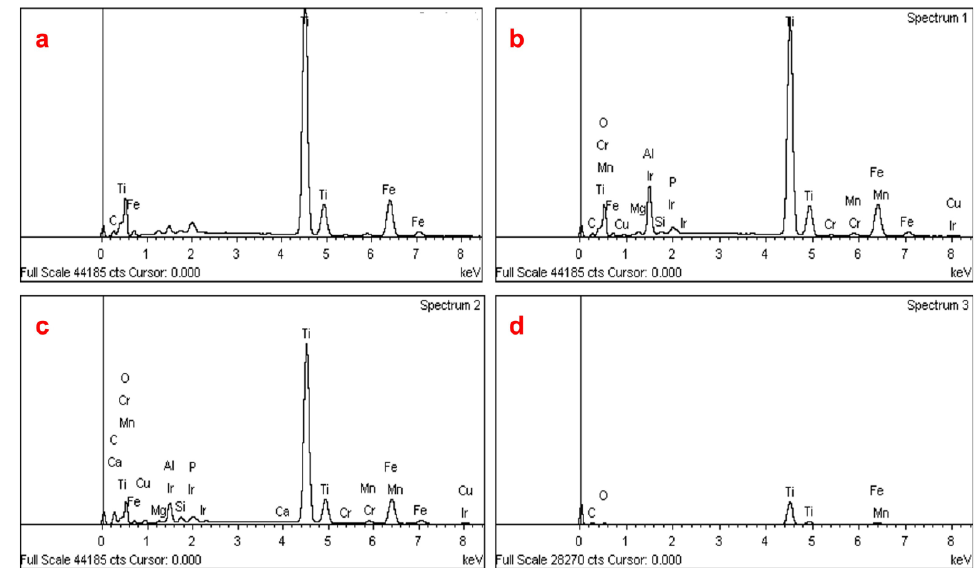
Figure 14. EDS analysis of the solid residue at ( a ) low magnification and ( b – d ) high magnification.